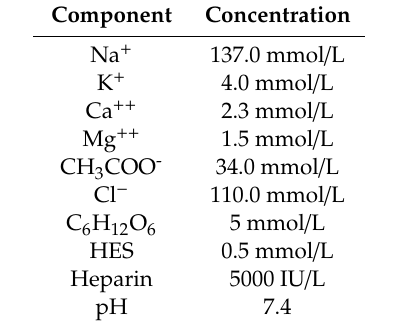
Table 1. Composition of the modified hydroxyethyl starch solution used as perfusion and flushing solution.